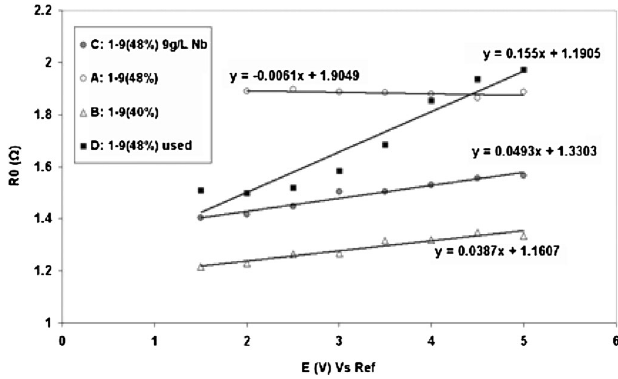
FIG. 6. R0 vs potential for A, B, C, and D